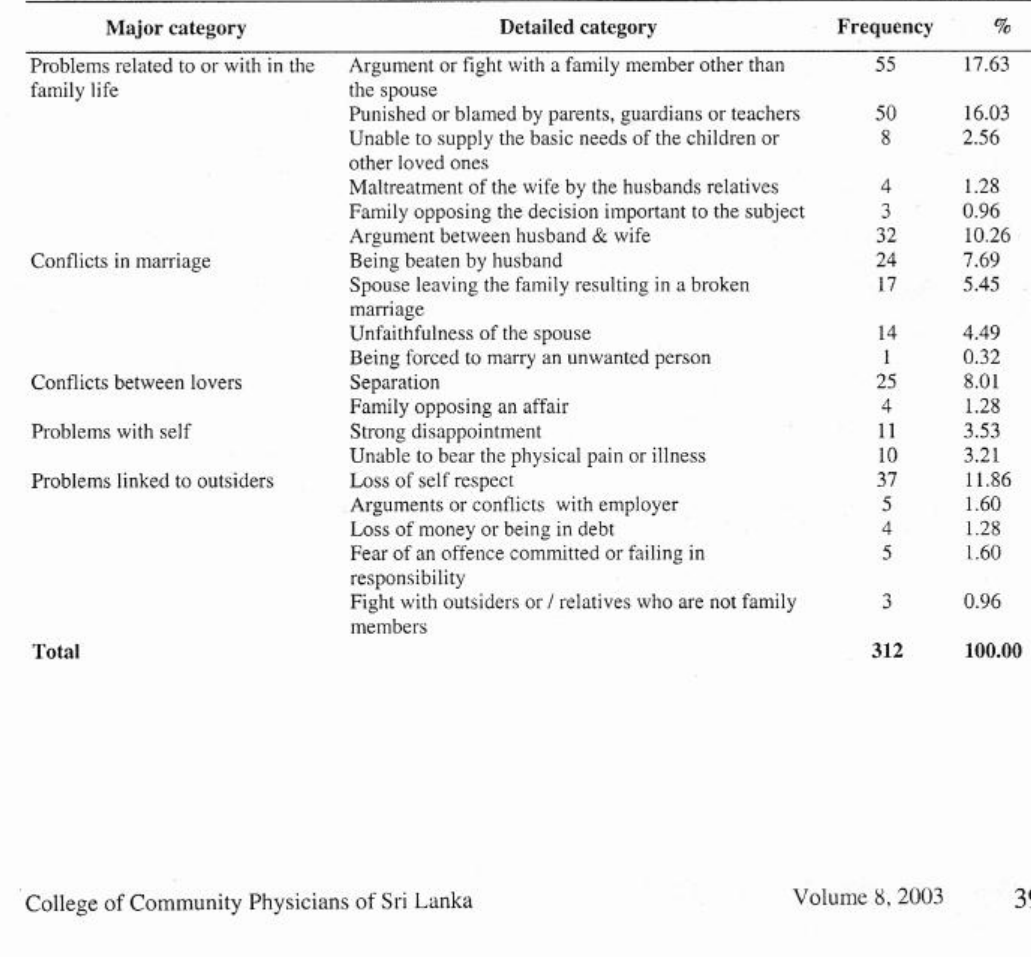
Table 1 : Precipitating events leading to attempted